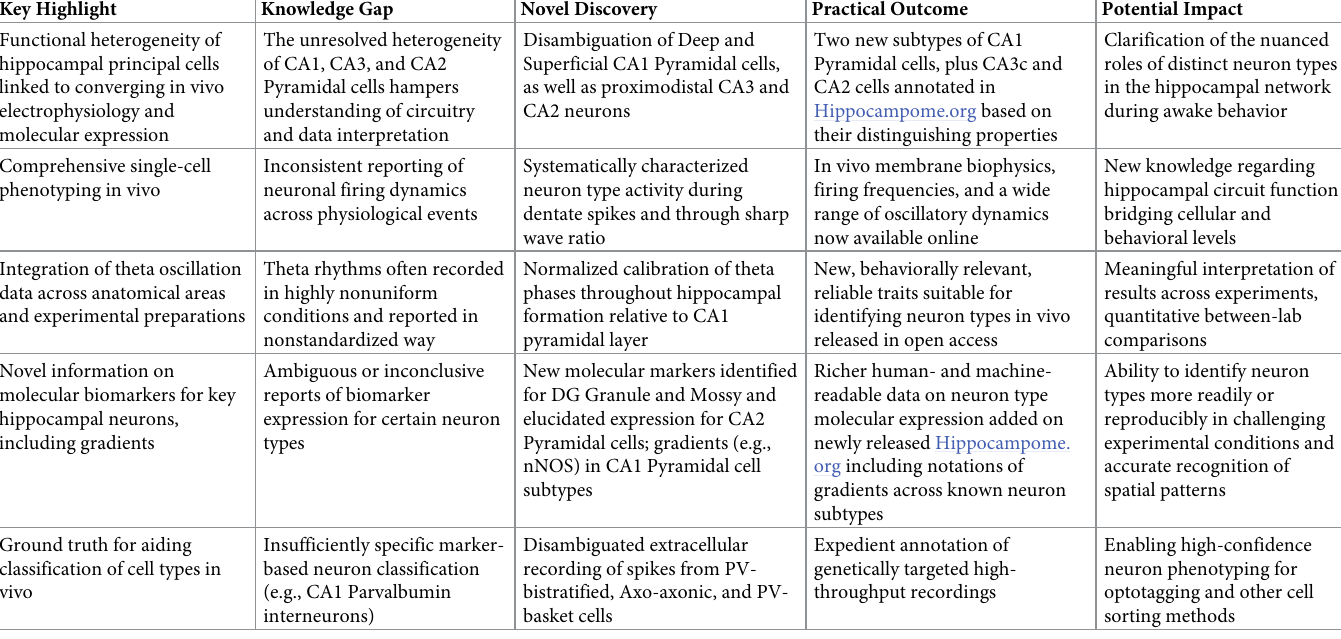
Table 3. A summary of some novel discoveries and their potential